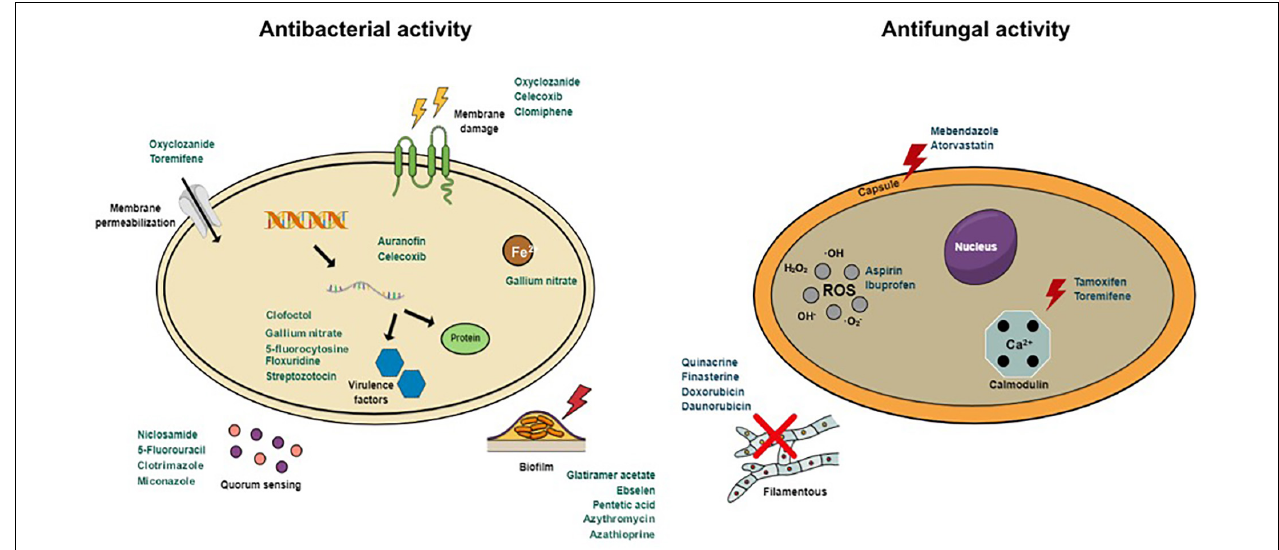
FIGURE 1 | Antibacterial and antifungal mechanisms of action of repurposed